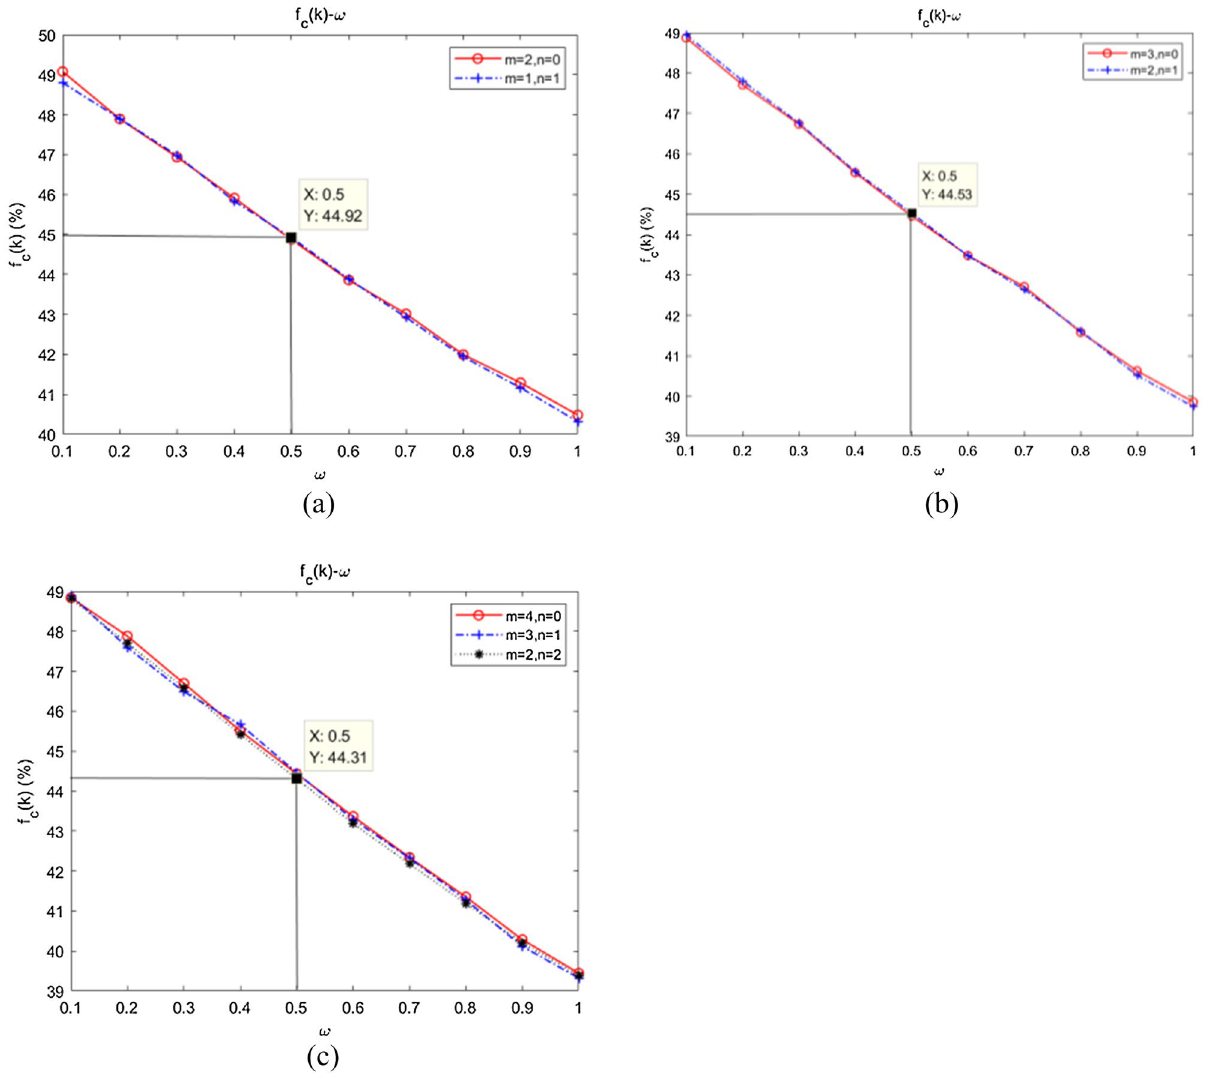
Figure 9. Dependence of the emergence of collaboration on intra-community attachment and inter- community attachment. ( a ) k ≈ 4 ; ( b ) k ≈ 6 ; ( c ) k ≈ 8